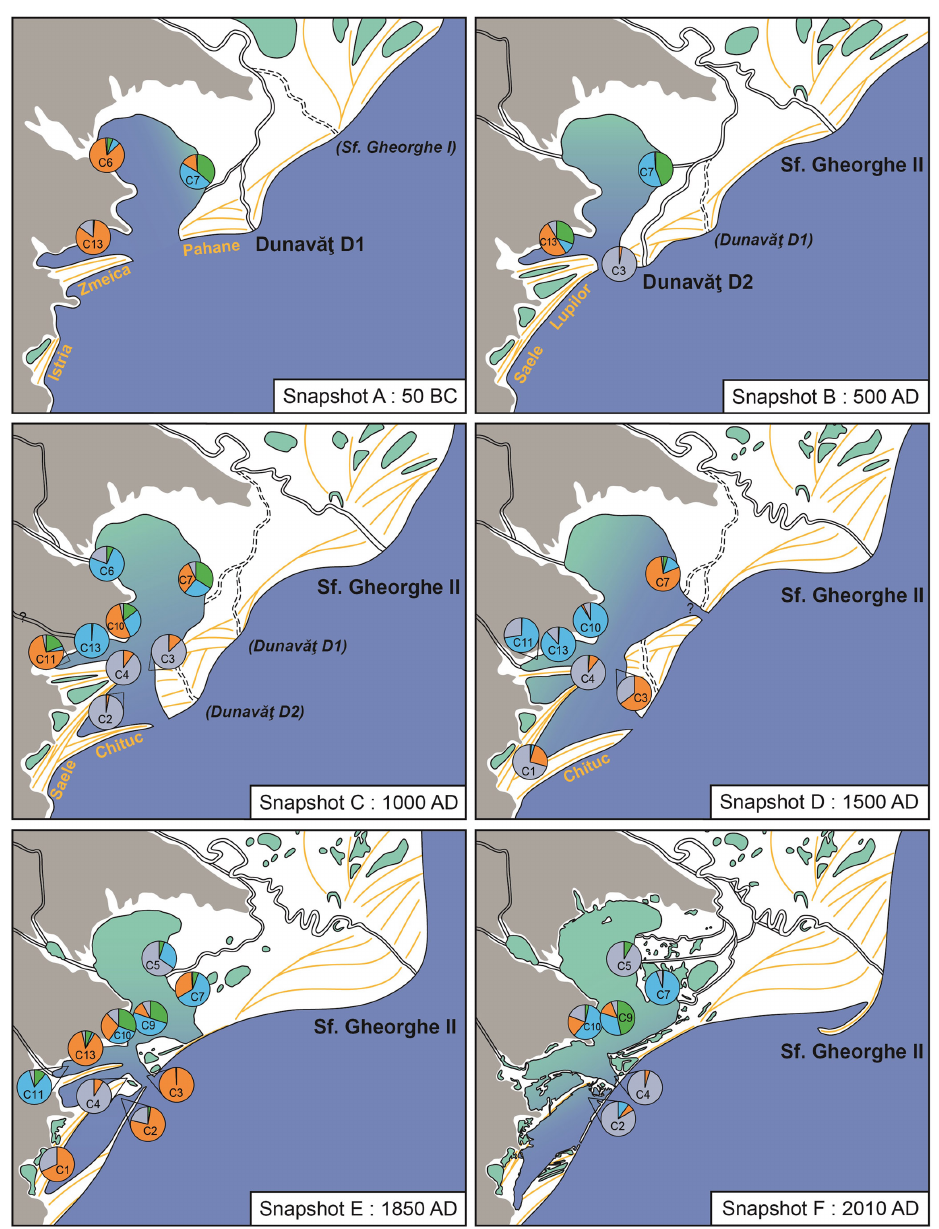
Figure 8. Snapshot reconstructions of the evolution of the RSL and their mollusc biota. The names of major sand barriers are indicated in yellow, while those of deltaic lobes are in black. The names in parentheses and italic font are currently inactive lobes. Pie charts indicate the relative abundance of the three associations in the time interval of ± 50 years of the indicated snapshot: blue – Association I (freshwater); green – Association II (Pontocaspian), orange – Association III (marine), grey – rest of the group. Water colours indicate a salinity gradient: blue is Black Sea influence (18psu); green is river influence (0psu). Note the freshening of the system and according changes in species associations with the decreasing influence of mesohaline waters from the Black